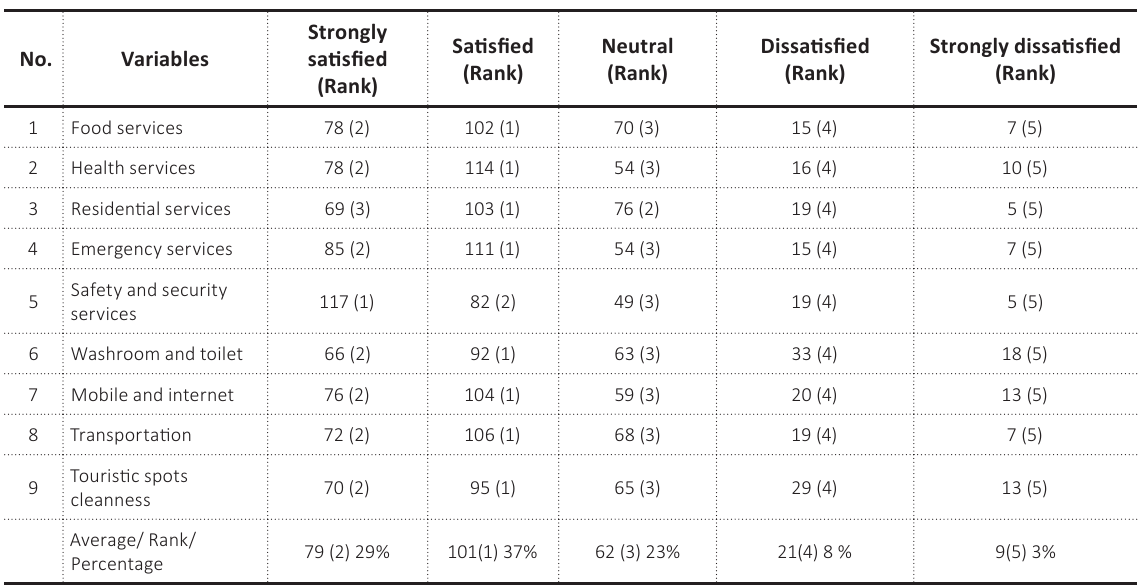
Source: Authors’ elaboration.